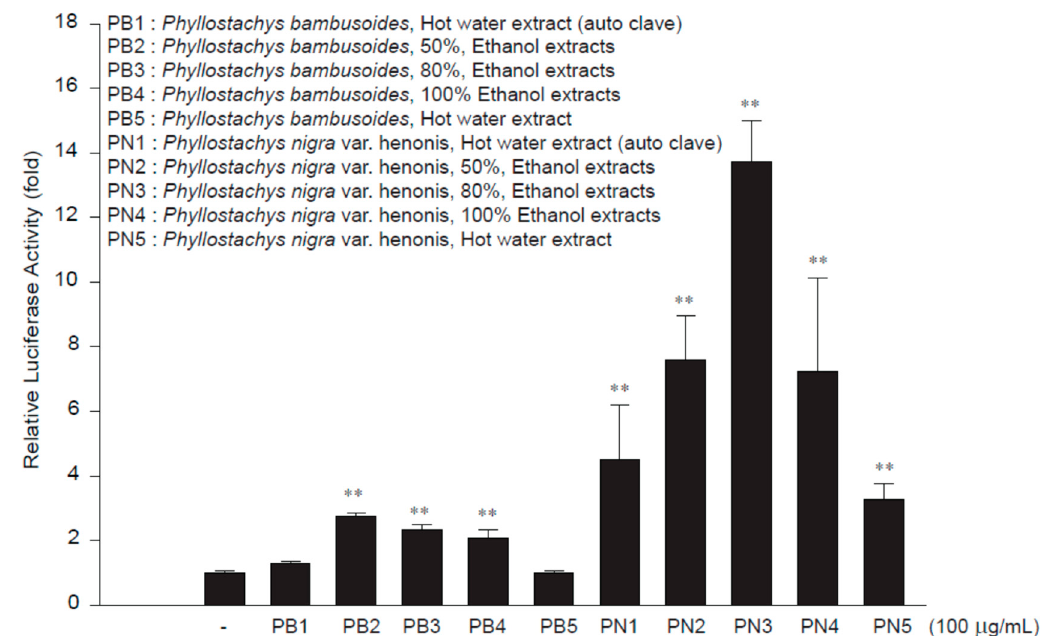
Figure 1. NAD(P)H quinone oxidoreductase-1 (NQO1)-antioxidant response element (ARE) luciferase activity of bamboo stem extract in HepG2 cells. NQO1-ARE luciferase activity was measured on the lysates of HepG2 cells that were stably transfected with the NQO1-ARE luciferase construct exposed to extract from P. bambusoides (PB) and P. nigra var. henonis (PN) for 12 h. Data represent the mean ± S.D. of three replicates; ** p < 0.01, significant versus vehicle-treated control.